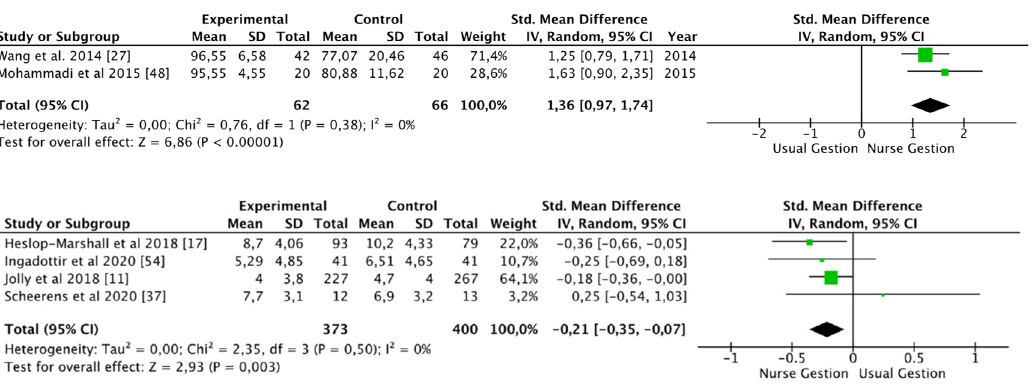
Figure 3. Activities of daily living (Barthel scale) and hospital anxiety and depression scale